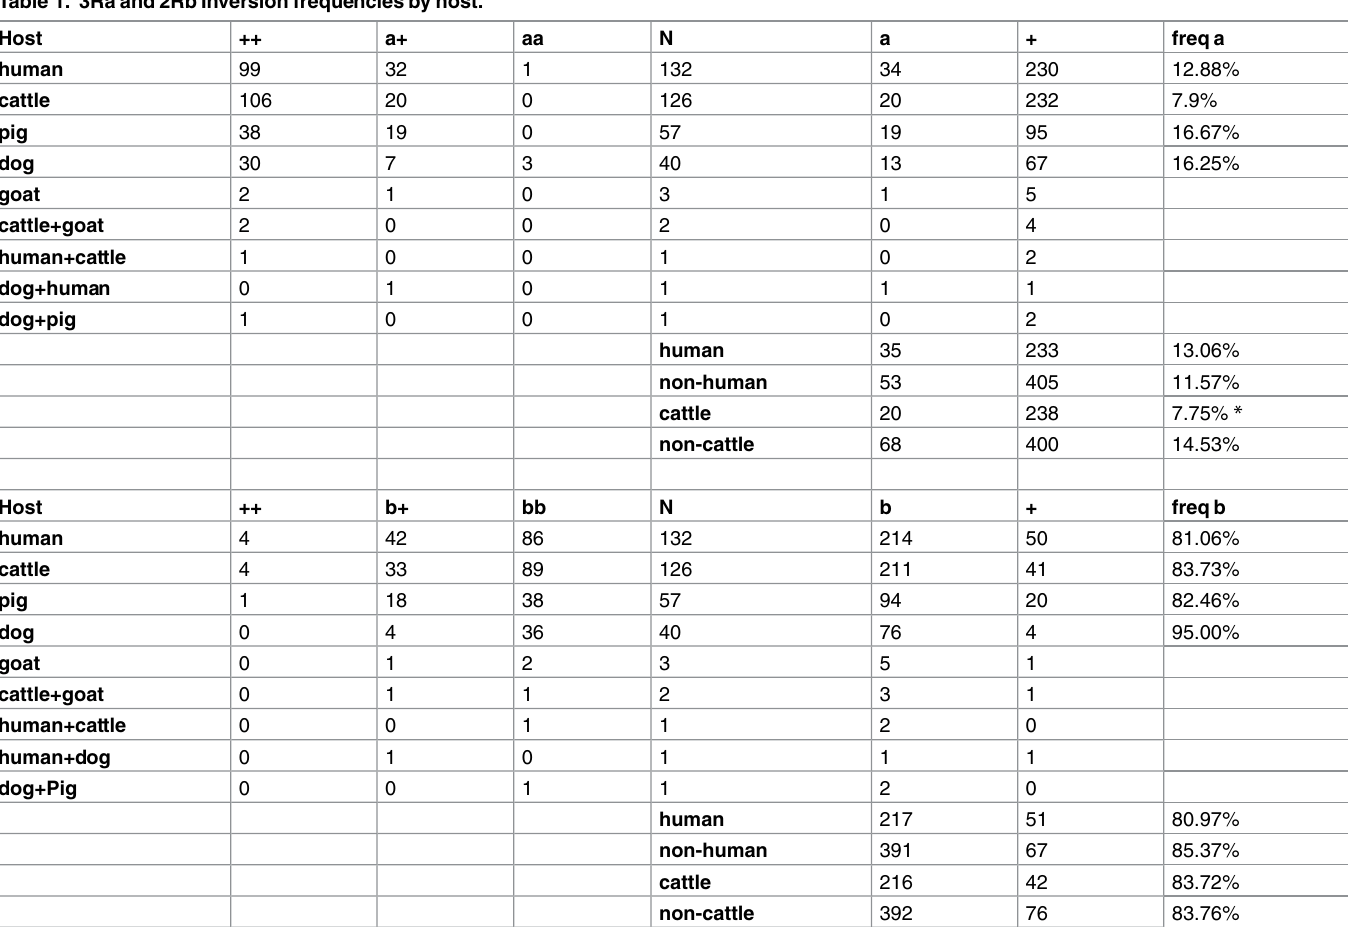
Table 1. 3Ra and 2Rb Inversion frequencies by host.